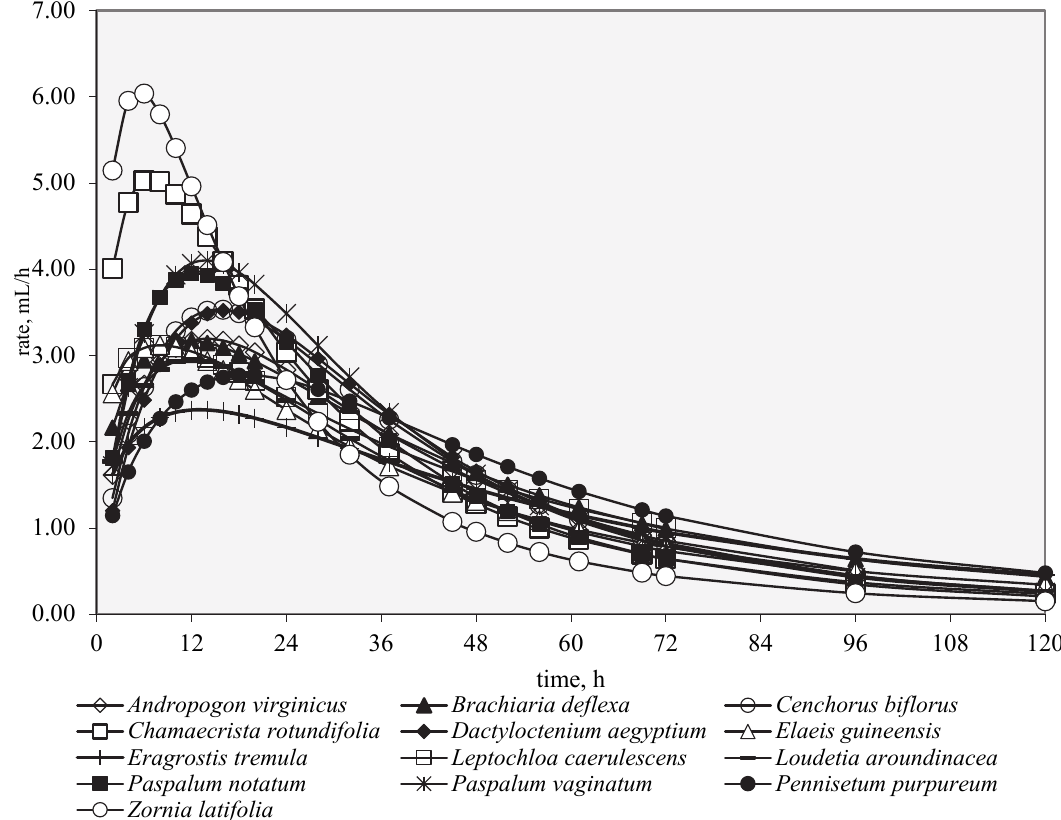
Figure 2. In vitro fermentation rate over time (120 h) for forage species.